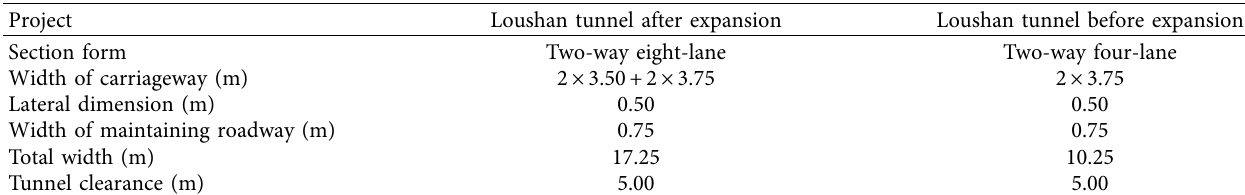
Figure 5: Results of CEEMD-MPE-HT time-frequency analysis. (a) Decomposition results of EMD. (b) IMF marginal spectrum. Table 1: Basic design parameters of expanded excavation of the Loushan tunnel (unit: